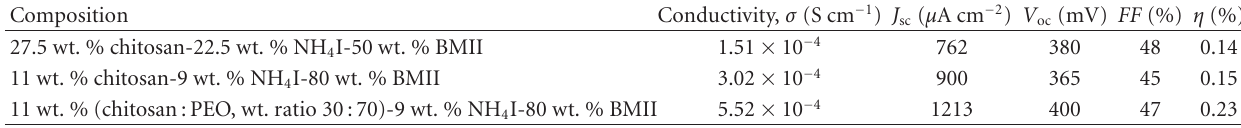
Table 3: V oc , J sc , FF , and η of black rice anthocyanin DSSCs using various compositions of electrolyte in gel form.